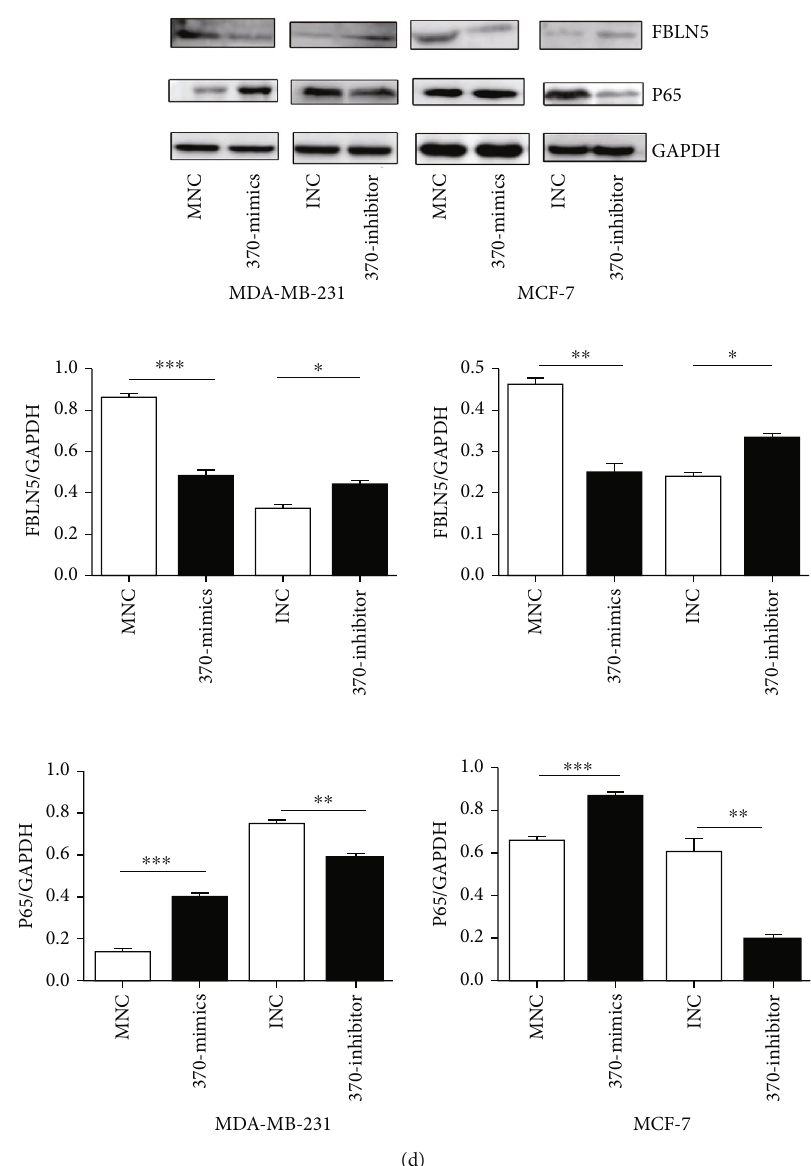
Figure 4: miR-370-3p targets and inhibits FBLN5 and activates the NF- κ B signaling pathway. (a) Quantitative RT-PCR was used to detect the expression of FBLN5 in breast cancer cells and them transfected with MNC, 370-mimics, INC, and 370-inhibitor. ∗∗∗ P < 0 : 001 , ∗∗ P < 0 : 01 . (b) The binding sites of miR-370-3p seed region and 3 ′ -UTR of FBLN5 mRNA were predicted. (c) The luciferase reporter gene analysis was used to detect the e ff ect of miR-370-3p on the stability of FBLN5 mRNA. ∗∗∗ P < 0 : 001 . (d) Western blot was used to detect the expression of FBLN5 and p-p65 in breast cancer cells transfected with MNC, 370-mimics, INC, and 370 -inhibitor. ∗∗∗ P < 0 : 001 , ∗∗ P < 0 : 01 , ∗ P < 0 : 05